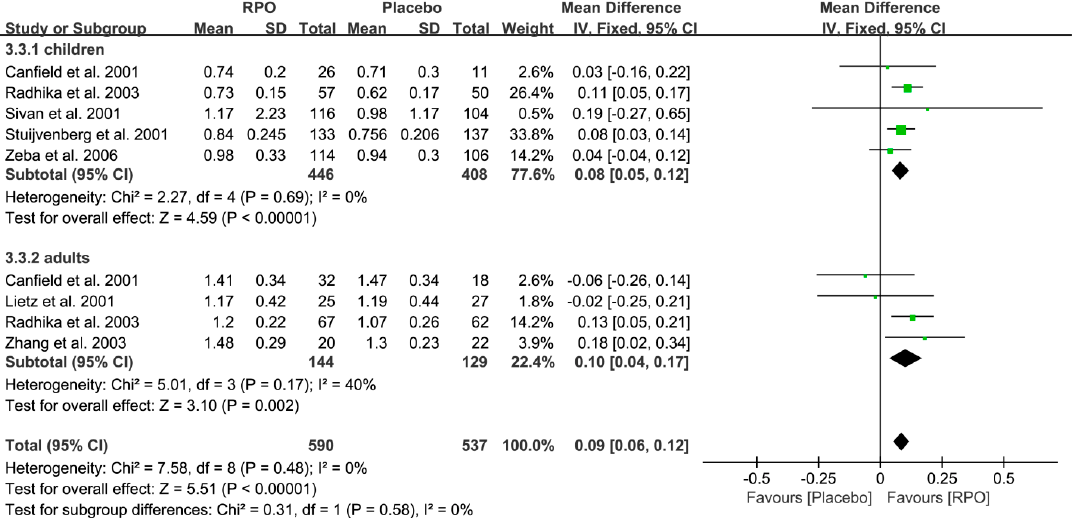
Figure 3. Subgroup analysis of serum retinol levels ( μ mol/L) following red palm oil (RPO) intervention in children and adults (RPO group vs. placebo group). CI: confidence interval.